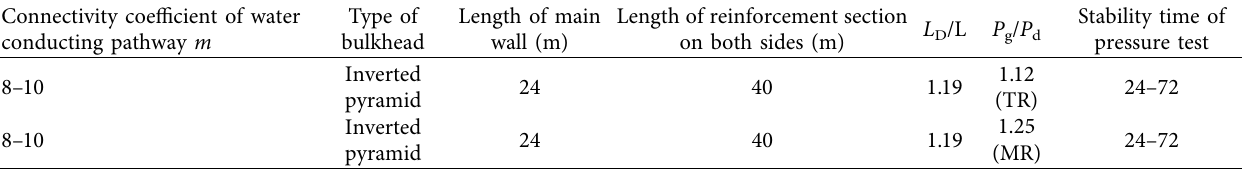
Table 3: Connectivity coefficients of water conducting pathway at the interface between bulkhead and surrounding rock of Panel No. 21102. Connectivity coefficient of water conducting pathway m